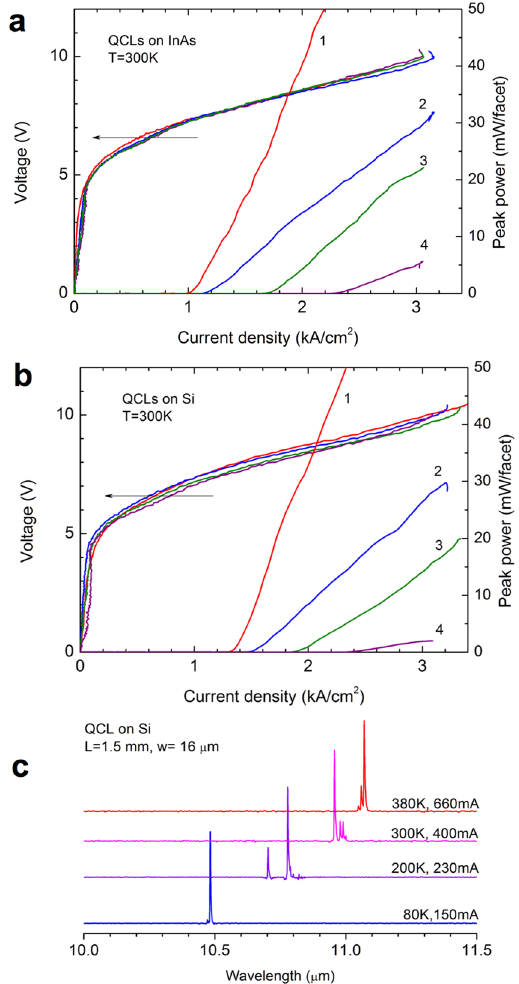
Figure 3. Characteristics of the studied QCLs. L – resonator length, w – ridge width. ( a ) Voltage-current and light-current characteristics of QCLs grown on InAs. 1 – L = 3.5 mm, w = 21 µ m; 2 – L = 2.3 mm, w = 14 µ m; 3 – L = 1.2 mm, w = 17 µ m; 4 – L = 0.7 mm, w = 17 µ m. ( b ) Voltage-current and light-current characteristics of QCLs grown on Si. 1 – L = 3.0 mm, w = 20 µ m; 2 – L = 1.5 mm, w = 16 µ m; 3 – L = 1.15 mm, w = 15 µ m; 4 – L = 0.6 mm, w = 14 µ m. ( c ) Emission spectra of a QCL grown on Si measured at different